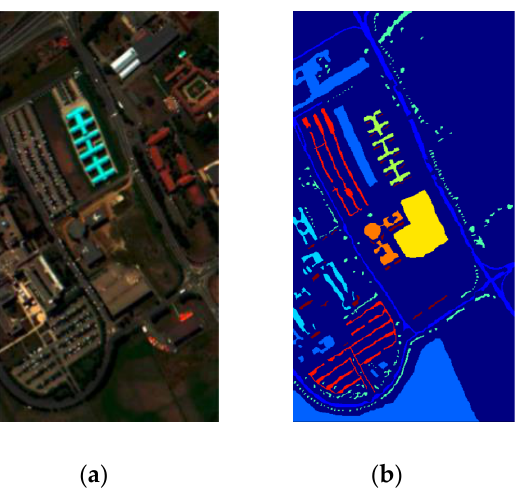
Figure 7. Pavia University dataset. ( a ) The false-color image. ( b ) The ground-truth map.